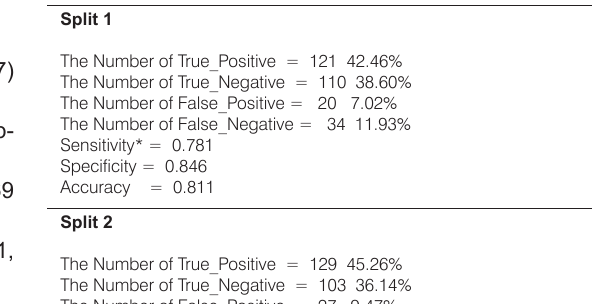
The testing of models (splits 1-6) against external qualitative data on biodegradability (n=285). True positive means a prediction where the biodegradability is modeled correctly and classified a chemical as biodegradable, analogical definitions for “true negative”, “false positive”, Split 1